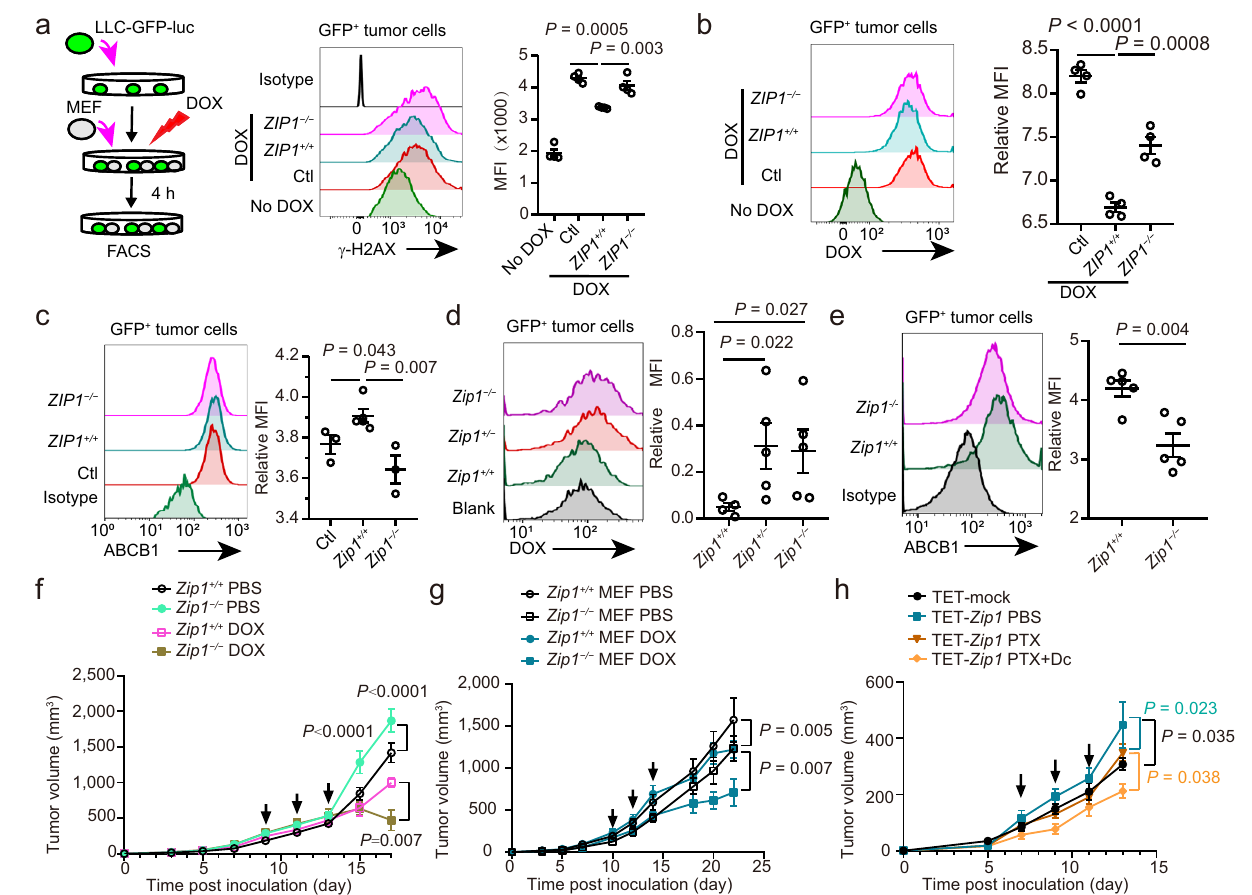
Fig. 6 | ZIP1 + fi broblasts promote chemoresistance of lung cancer cells in vitro and in vivo. a Experimental design (left) and results of DNA damage ( γ -H2AX expression) in LLC-GFP-luc cells co-cultured with Zip1 +/+ or Zip1 − / − MEFs with DOX (3 μ M) treatment. Mean±SEM, n =4. Two-tailed t -test. b DOX accumulation in LLC-GFP-luc tumour cells co-cultured with Zip1 +/+ or Zip1 − / − MEFs with DOX(3 μ M) treatment. Mean±SEM, n =4. Two-tailed t -test. c ABCB1 expression in LLC-GFP- luc tumour cells co-cultured with Zip1 +/+ or Zip1 − / − MEFs for 24h. Mean±SEM. Ctl, Zip1 +/+ : n =3; Zip1 − / − : n =6. Two-tailed t -test. d DOX accumulation in LLC-GFP-luc tumour cells 6h after DOX injection in tumour-bearing Zip1 +/+ , Zip1 +/ − and Zip1 − / − mice. DOX (10mg/kg) was intravenously injected into the mice at day 10 post- transplantation. Mean±SEM. Zip1 +/+ : n =4; Zip1 +/ − , Zip1 − / − : n =5. One-tailed Kruskal – Wallis test. e ABCB1 expression in LLC-GFP-luc cells transplanted into Zip1 +/+ and Zip1 − / − mice at day 10 post-transplantation. Mean±SEM, n =5. Two-